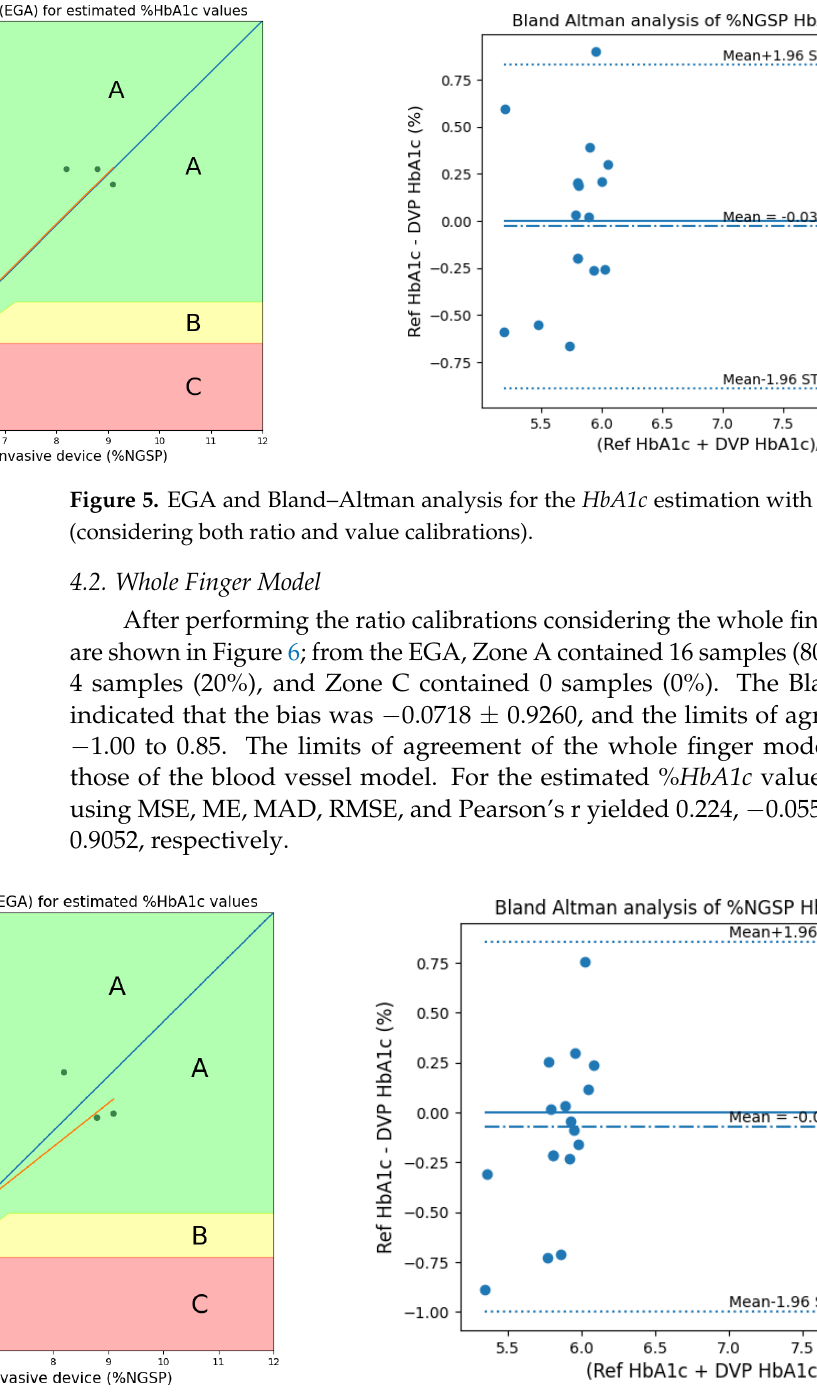
Figure 7. EGA and Bland–Altman analysis for HbA1c with the whole finger model (considering both ratio and value calibrations). 4.3. 𝑆𝑝𝑂 (cid:2870) Estimation For the estimated SpO (cid:2870) values obtained through the ratio calibration, the scatter plot and Bland–Altman analysis results are plotted in Figure 8. The Bland–Altman analysis provided a bias of − 0.0894 ± 3.293, and the limits of agreement ranged from − 3.38 to 3.20. For the estimated % SpO (cid:2870) values, statistical analysis using MSE, ME, MAD, and RMSE